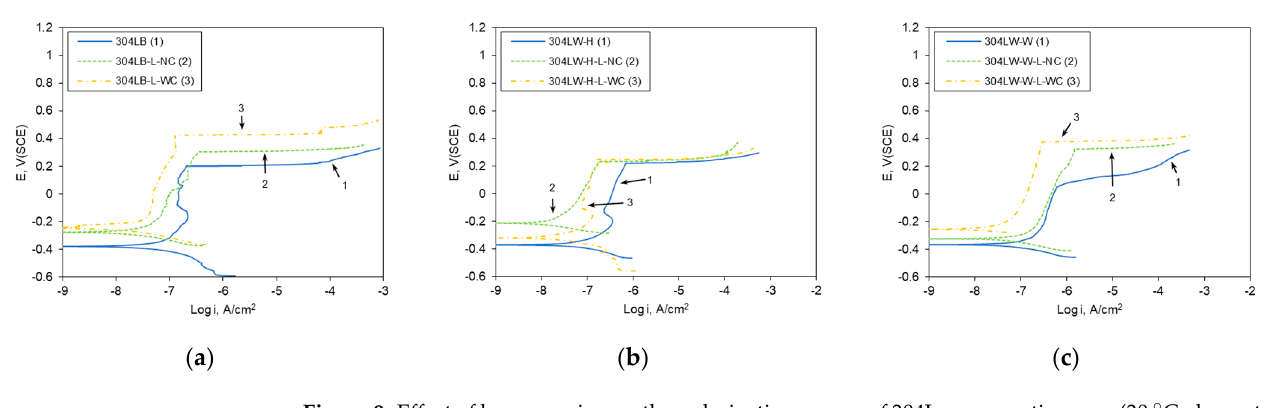
Figure 9. Effect of laser peening on the polarization curves of 304L-cross-section area (30 °C, deaerated 1% NaCl); ( a ) Base metal, ( b ) HAZ area, ( c ) Weldment.